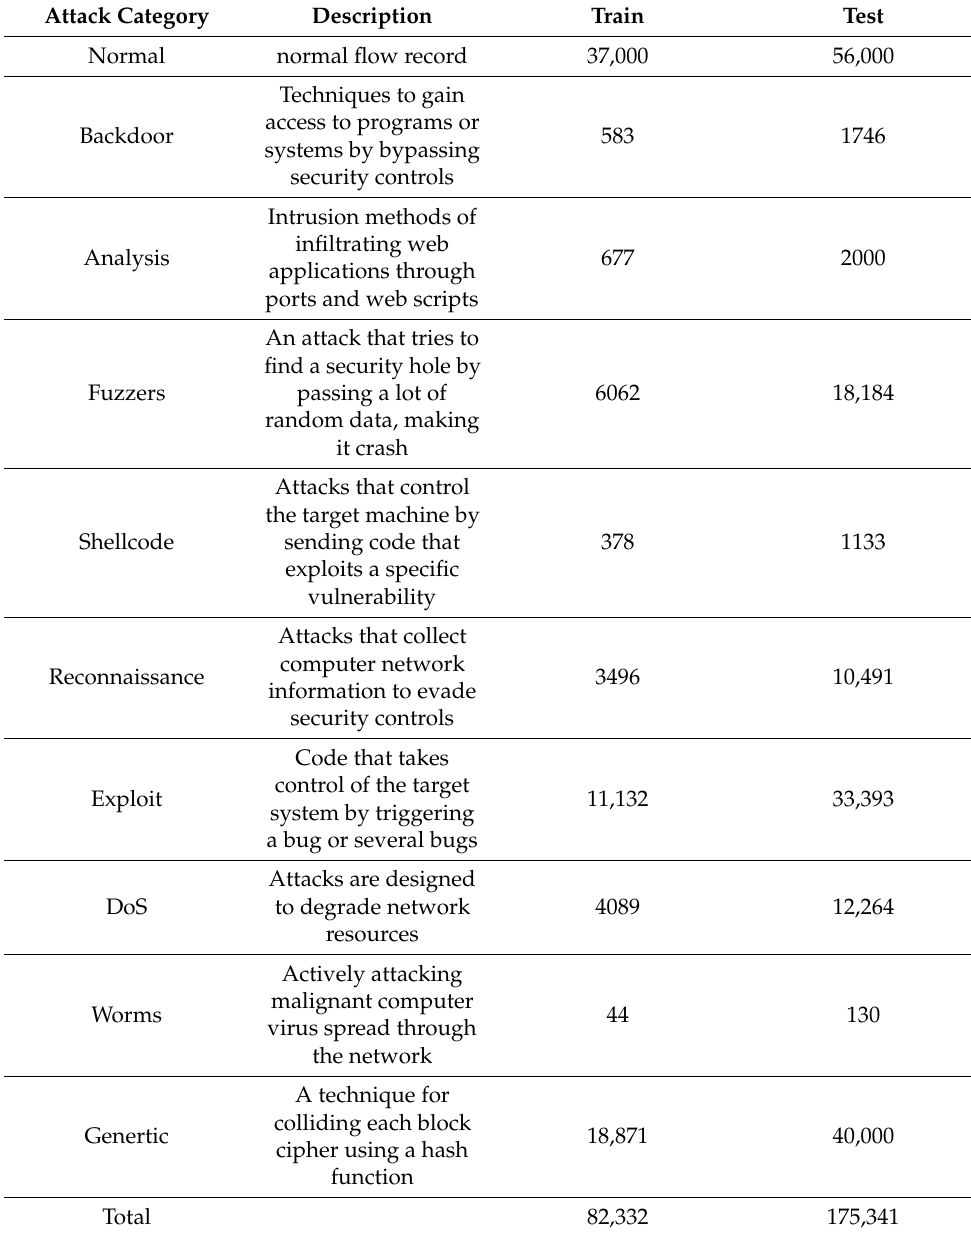
Table 3. Composition of UNSW-NB15